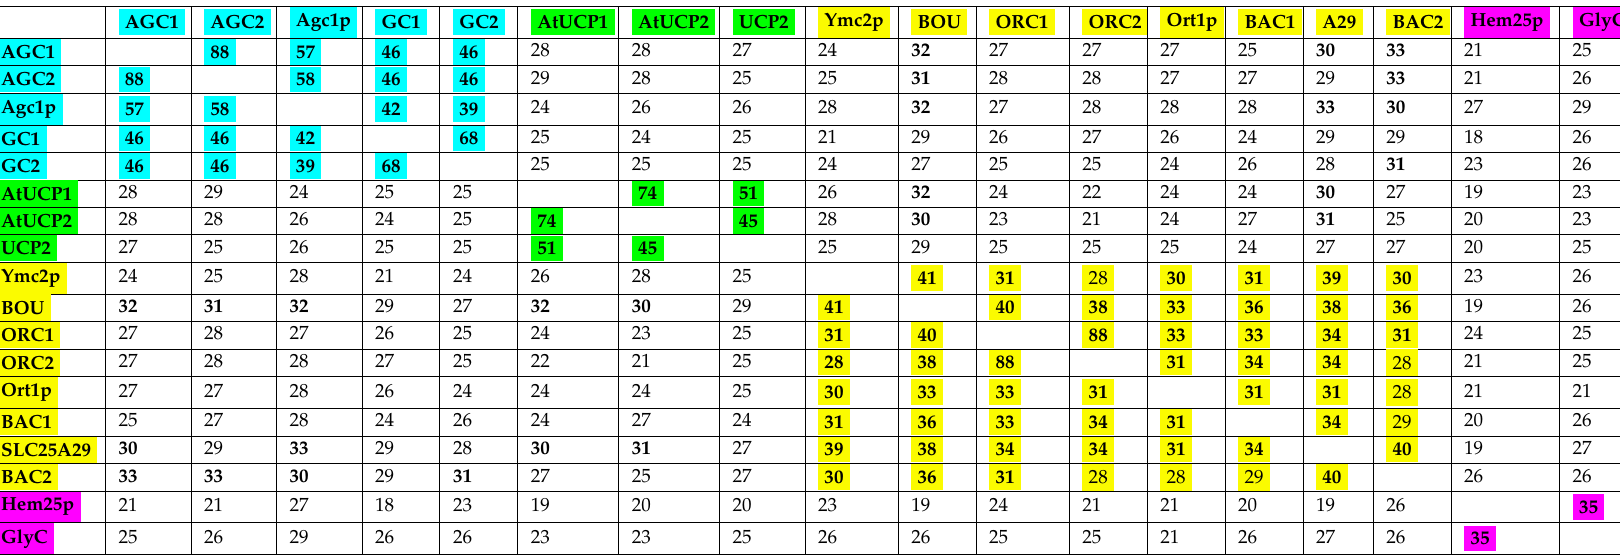
Table 1. Sequence identities between the MC domains (of amino acid-transporting mitochondrial carriers) in percentages, with identities of 30% and above indicated in bold. The four main carrier groups are indicated with the same colors as in Figure